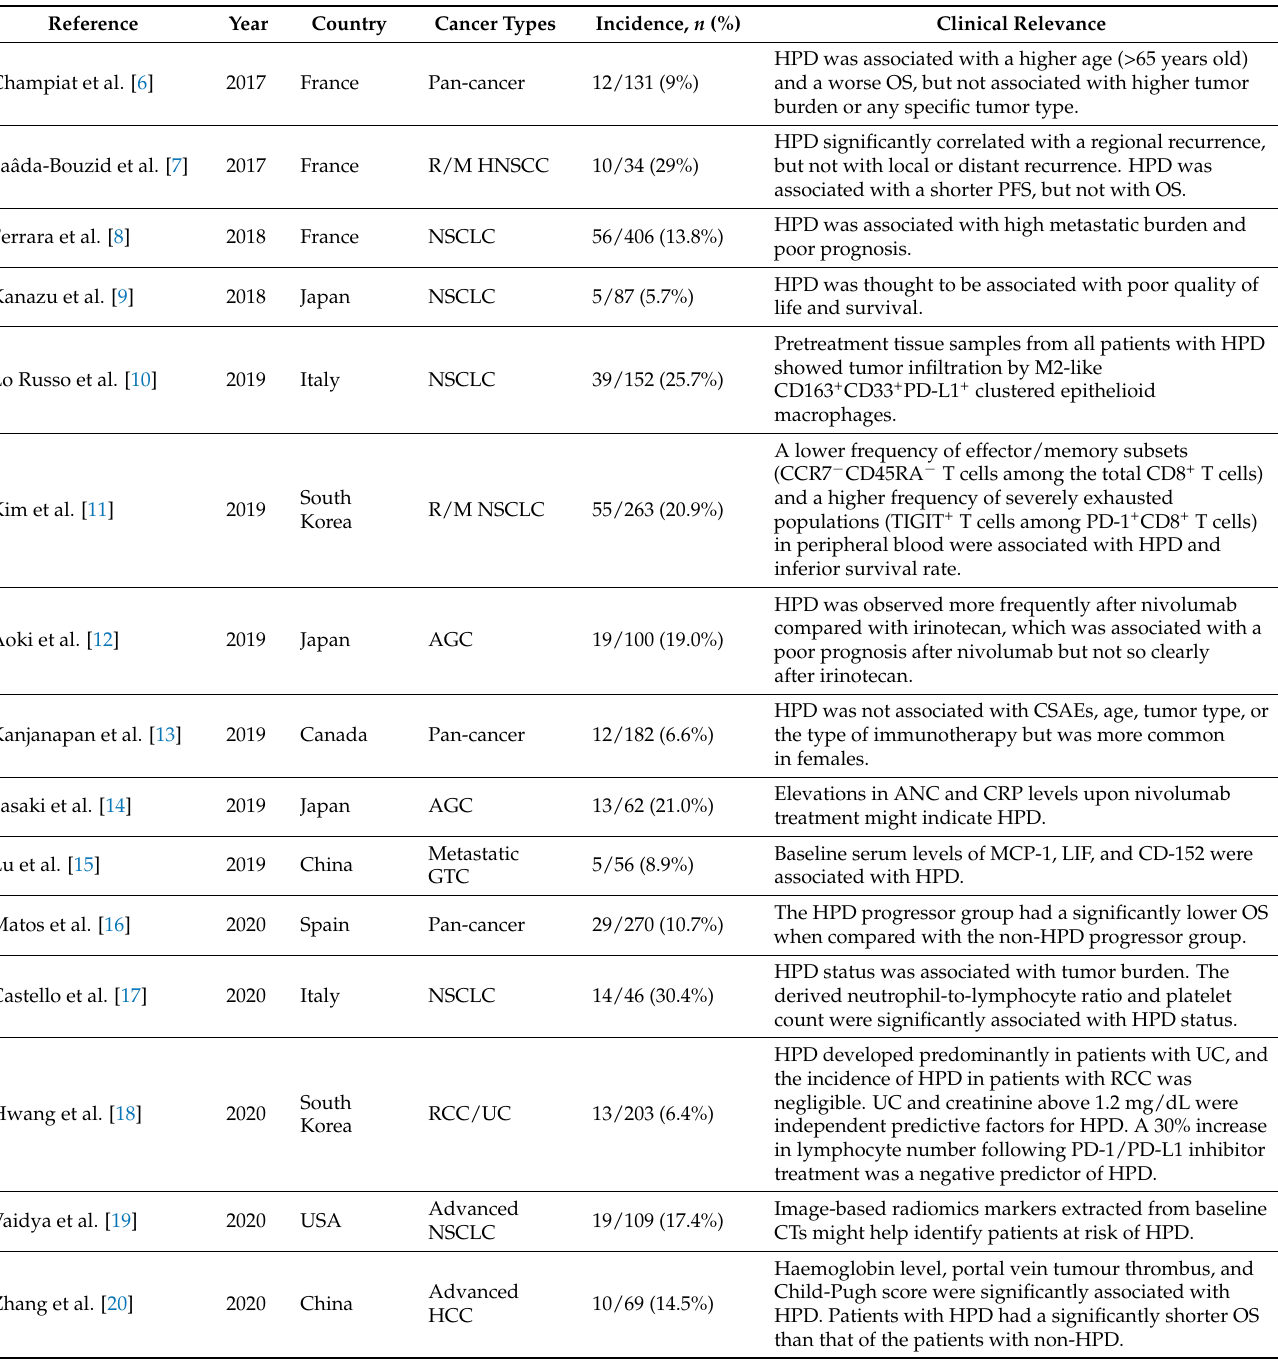
Table 1. Representative case series studies of HPD in multiple cancer